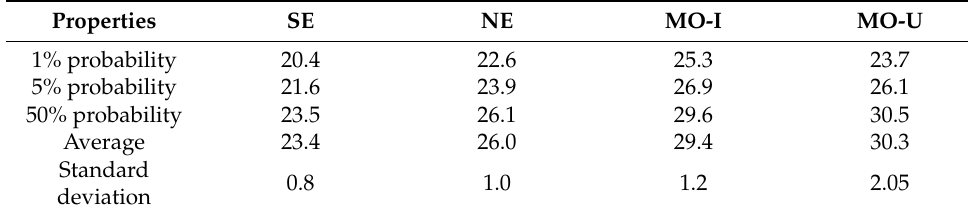
Figure 5. Weibull distribution plots of partial-discharge inception voltage (PDIV) for the distinctive liquids considered: SE—synthetic ester, NE—natural ester, MO-I—inhibited mineral oil, MO-U—uninhibited mineral oil. Shape—shape parameter of Weibull distribution function, Scale—scale parameter of Weibull distribution function, N—number of random variables. Table 3. Characteristic values of partial-discharge inception voltage (PDIV)